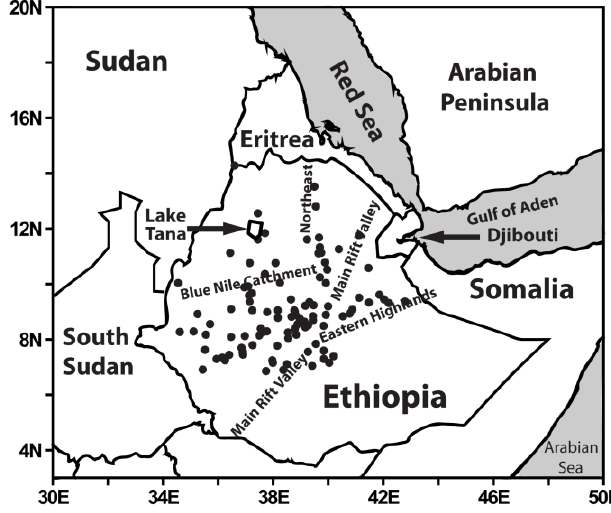
Figure 1. Regional map showing the locations of 100 Ethiopian rain gauge stations (solid circles) with data for 1970–1999 that were used for observed rainfall mapping and